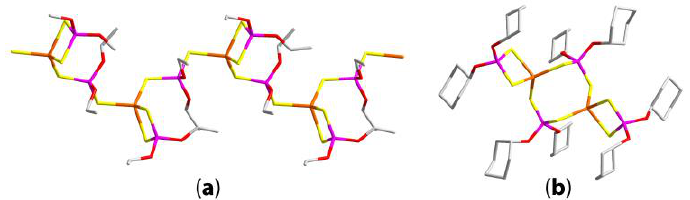
Figure 5. Aggregation in the crystals of ( a ) {Zn[S 2 P(OMe) 2 ] 2 } n ( 21 ) and ( b ) {Zn[S 2 P(OCy) 2 ] 2 } 2 ( 24 ). Additional colour code: phosphorus, pink.